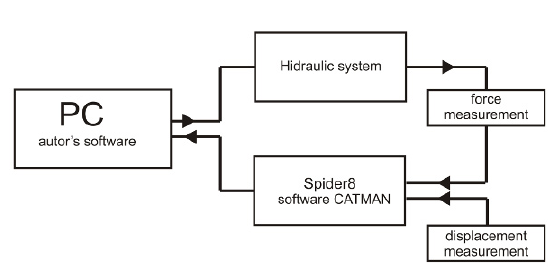
Figure 4. A flow chart for measuring